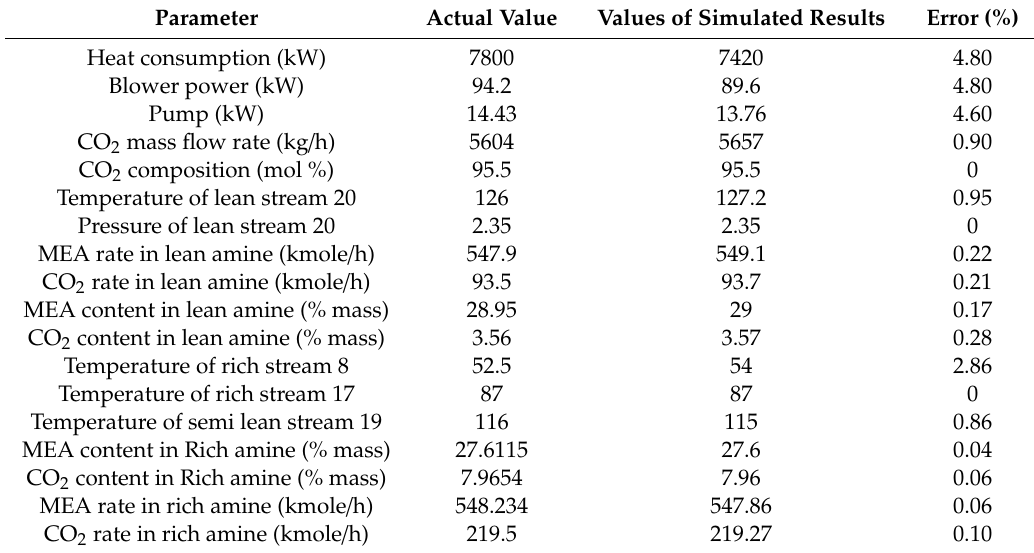
Table 5. Validation of simulated results with important parameters of the CCU